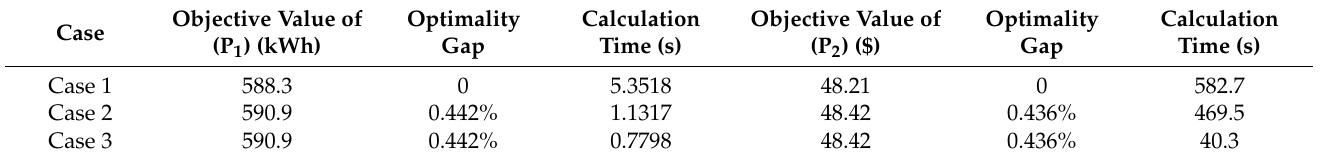
Table 1. Comparative results for the three tested